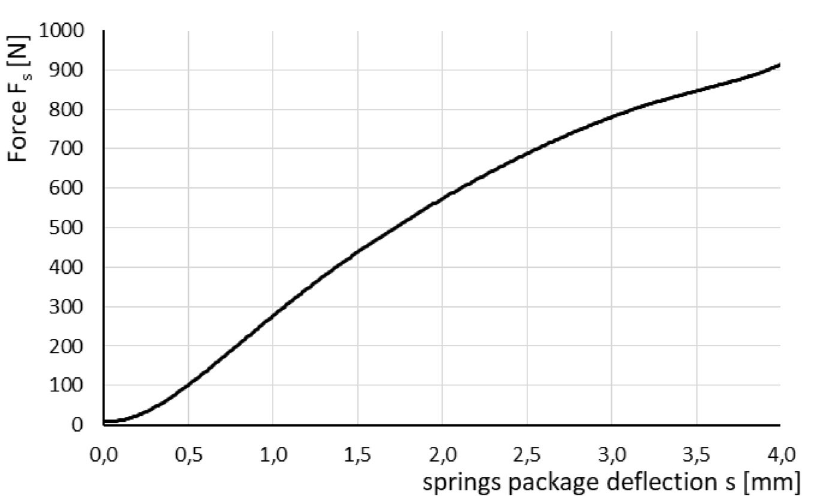
Figure 9. Characteristic of package of disc springs 13